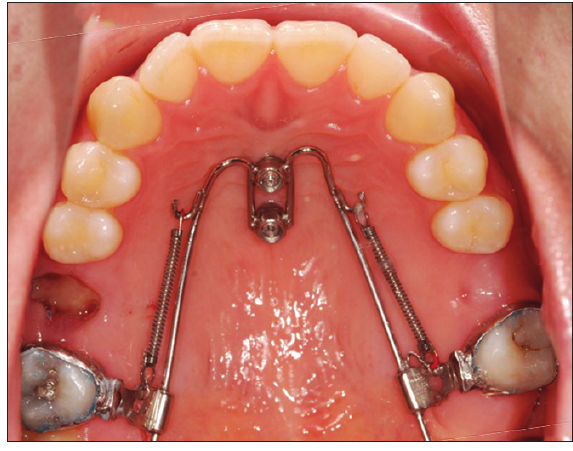
Figure 6. Occlusal view of the Mesialslider attached to two palatal mini-implants at the start of maxillary molar